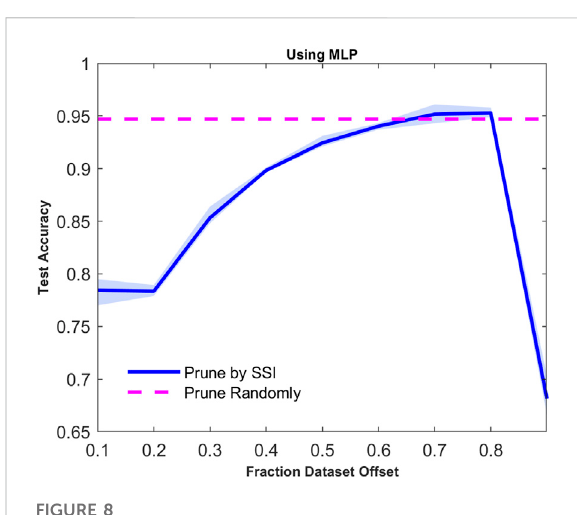
FIGURE 8 Test accuracyofMLP trained ononly10% subsetwhichslides along the samples in the ascending order of